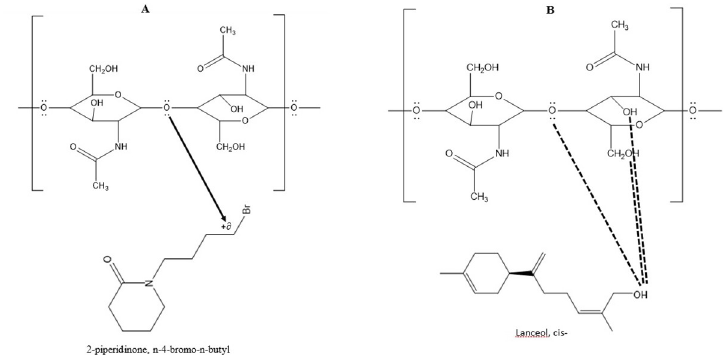
Fig 3. (A) Interaction of piperidinone, n-|4-bromo-n-butyl| with chitin of whitefly (B) Interaction of hydrogen of Lanceol, cis- with oxygen and hydroxyl group present in